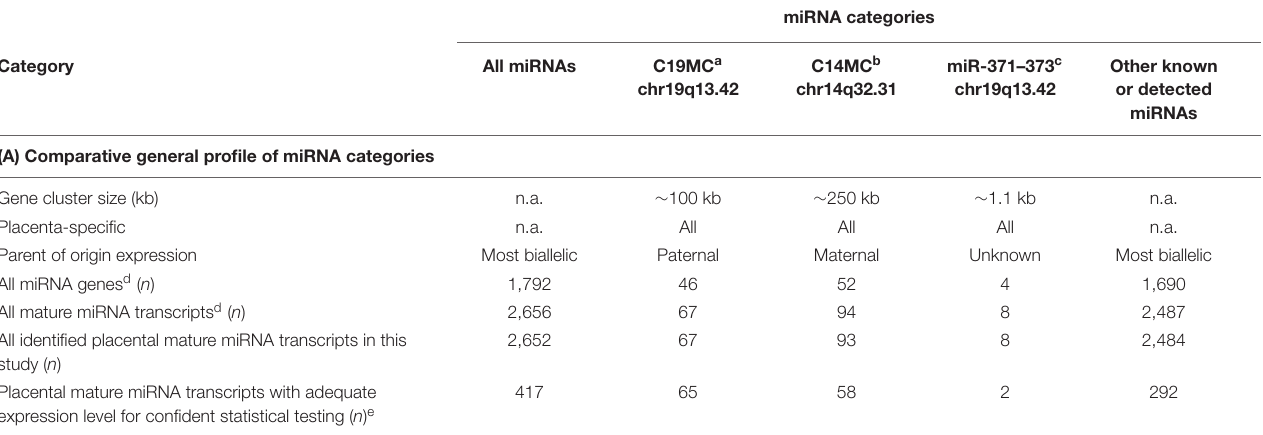
TABLE 2 | General profile and expression dynamics of placental